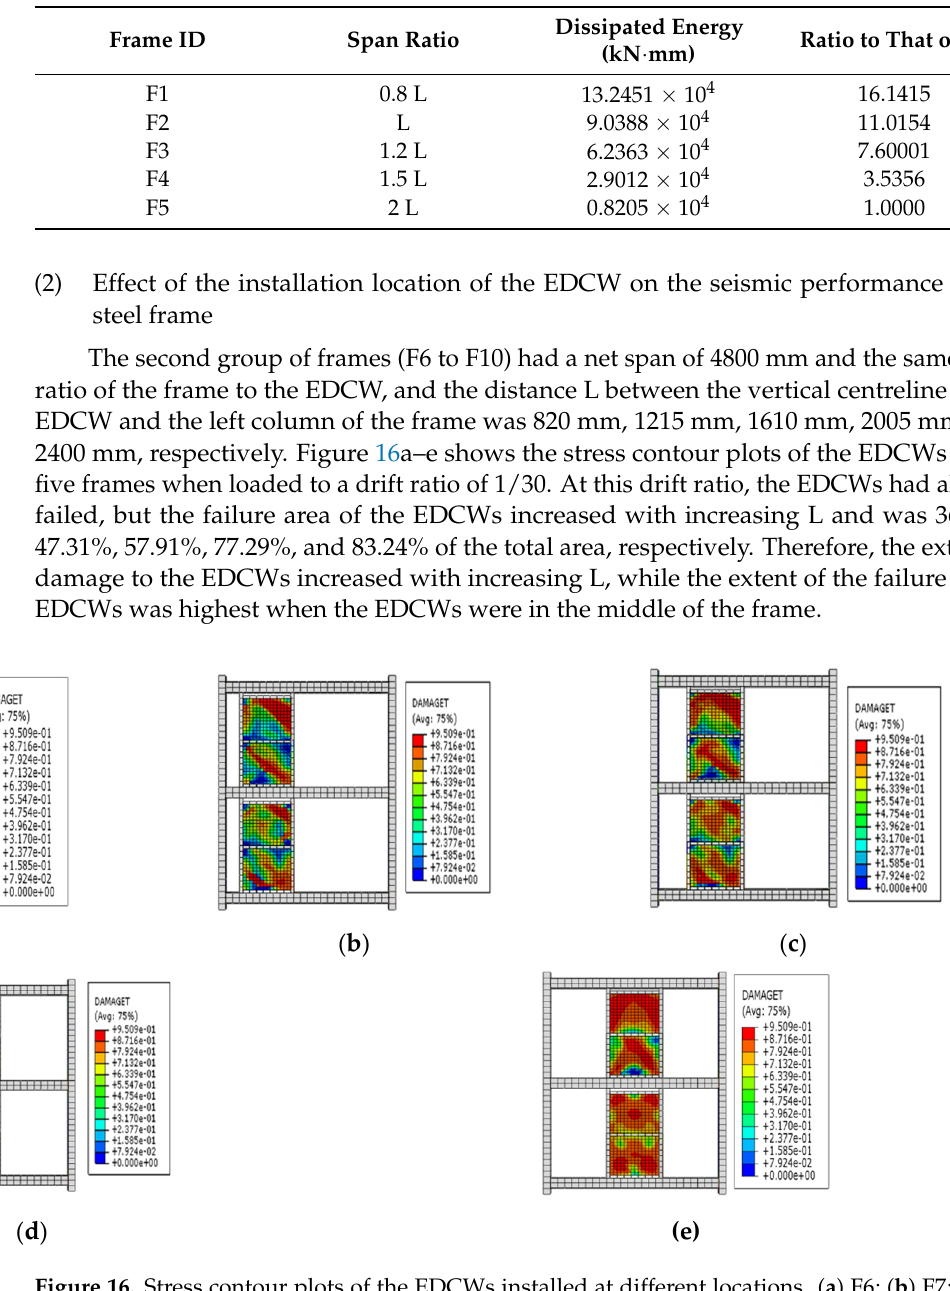
Figure 15. Hysteresis curves of the first group of frames. ( a ) F1; ( b ) F2; ( c ) F3; ( d ) F4; and ( e ) F5. Table 5. Cumulative energy dissipated by the EDCWs. Table 5. Cumulative energy dissipated by the EDCWs.